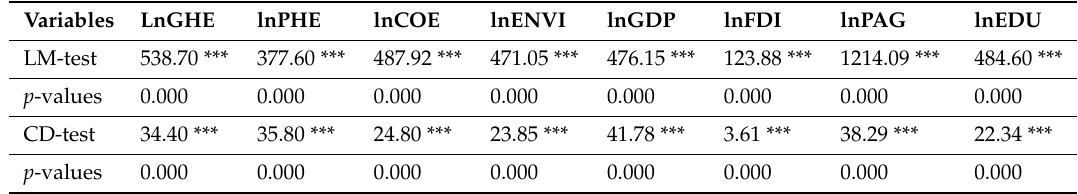
Table 3. Cross-Sectional Dependence